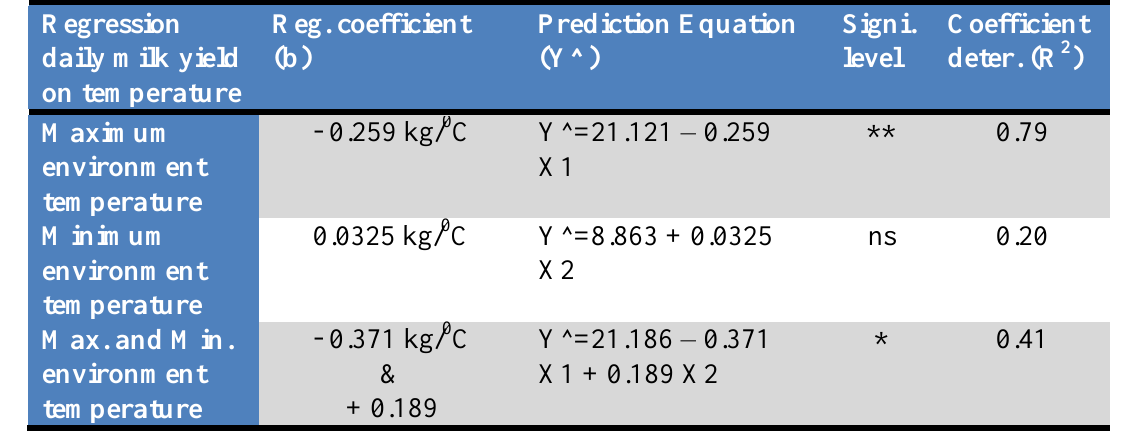
Table 4. Regression daily buffaloes milk yield on minimum and maximum Temperatures